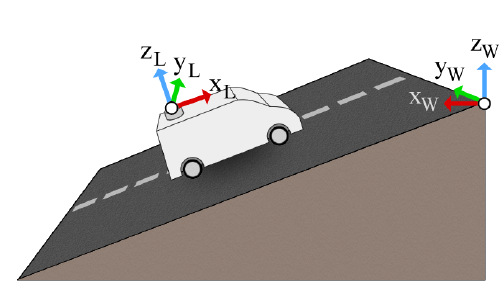
Figure 6. Definition of the different frames between the LiDAR sensor ( x L , y L , z L ) and the real world ( x W , y W , z W ).